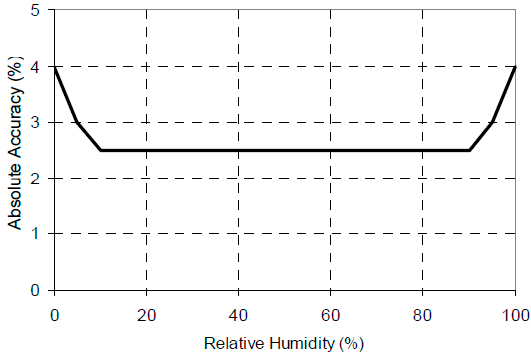
Figure A1. Humidity sensor accuracy plot (adopted from the specification of HOBO Pro v2).